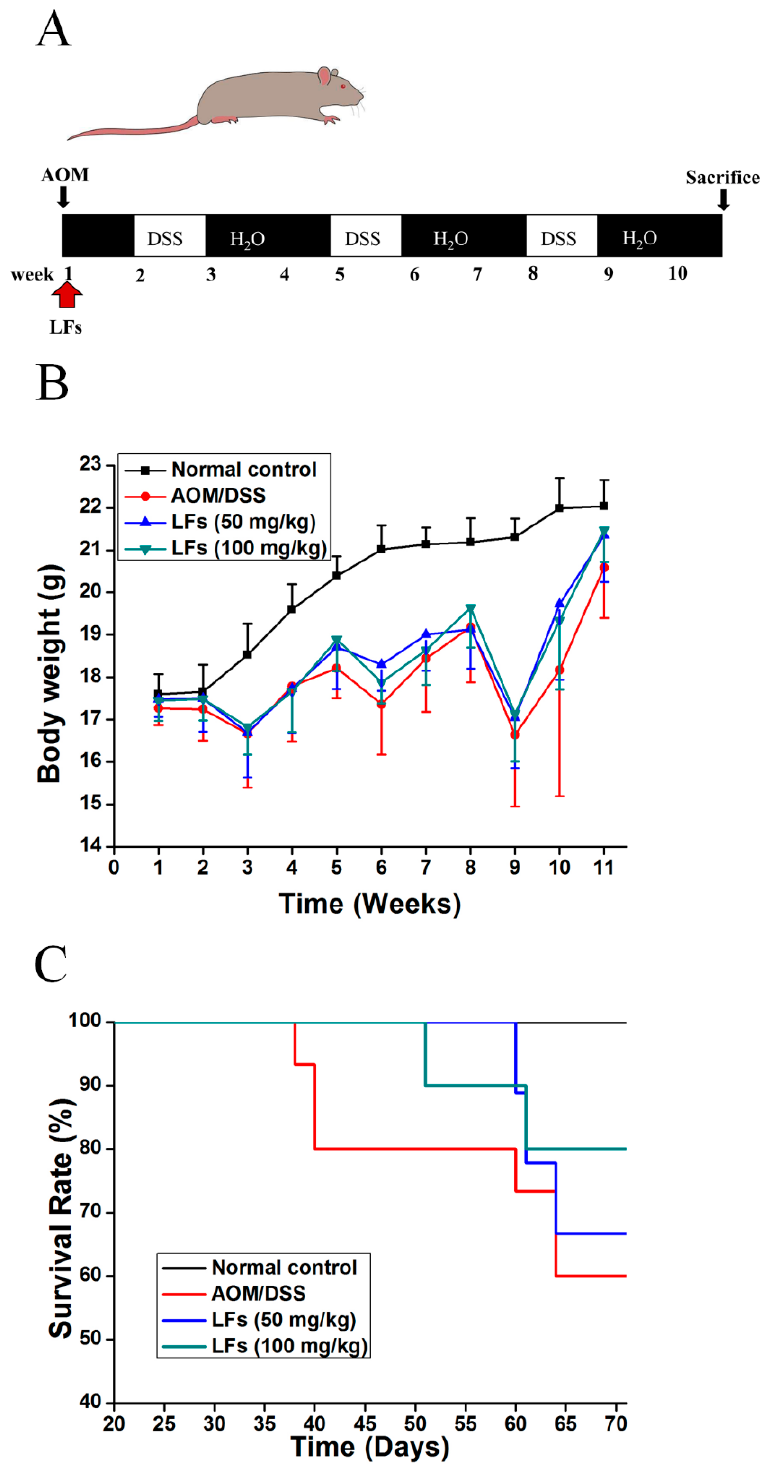
Figure 1. Effects of LFs on colitis-associated colon carcinogenesis were evaluated in C57BL/6 mice. ( A ) Schematic of administration of AOM, DSS and LFs to mice. Fifteen mice were set in the model control group, and 10 mice per group were set in other groups; ( B ) Effect of LFs on the body weight of mice. During experiment, mice were weighed once a week for 10 weeks; ( C ) Effect of LFs on the survival rate of mice. LFs prolonged animal survival. Data are presented as mean vs. control and model.